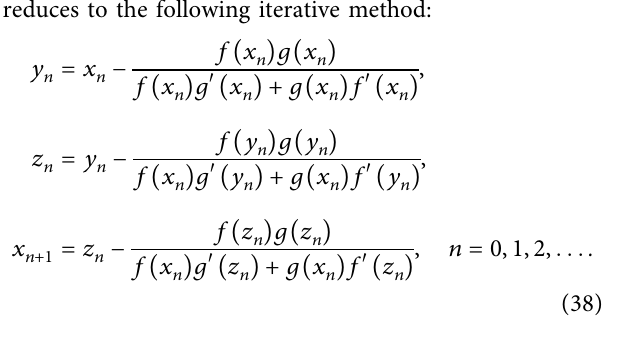
� 1, and τ � 1, Algorithm 3 1 1